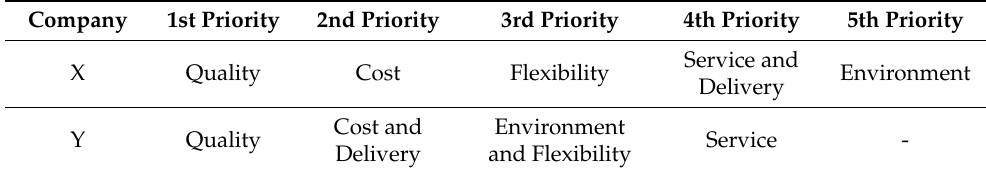
Table 1. Ranking of the companies’ competitive